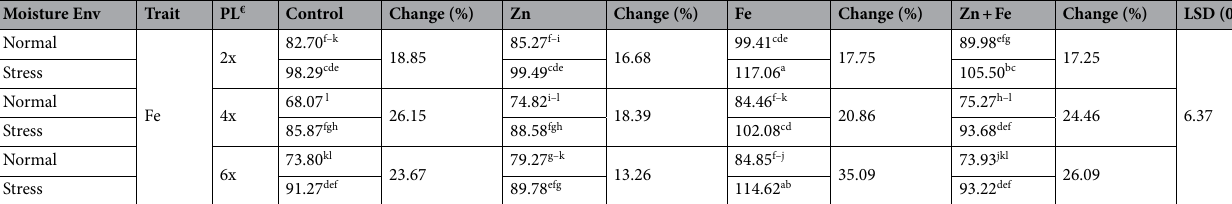
Table 3. Mean comparison of traits for different wheat ploidy levels in response to foliar application of Zn and Fe under two moisture environments. GY, Grain yield (g/m 2 ); NKS, Number of kernel per spike; TKW, Thousand kernel weight (g); KL, Kernel length (mm); KD, Kernel diameter (mm); PH, Plant height (cm); FLL, Flag leaf length (mm); FLW, Flag leaf width (mm); Zn, Grain zinc content (µg/g); Fe, Grain iron content (µg/g). ¥ For each trait, means followed by the same letter are not significantly different, using LSD test at 5% level of probability. δ Change by water stress relative to normal irrigation conditions. € Ploidy